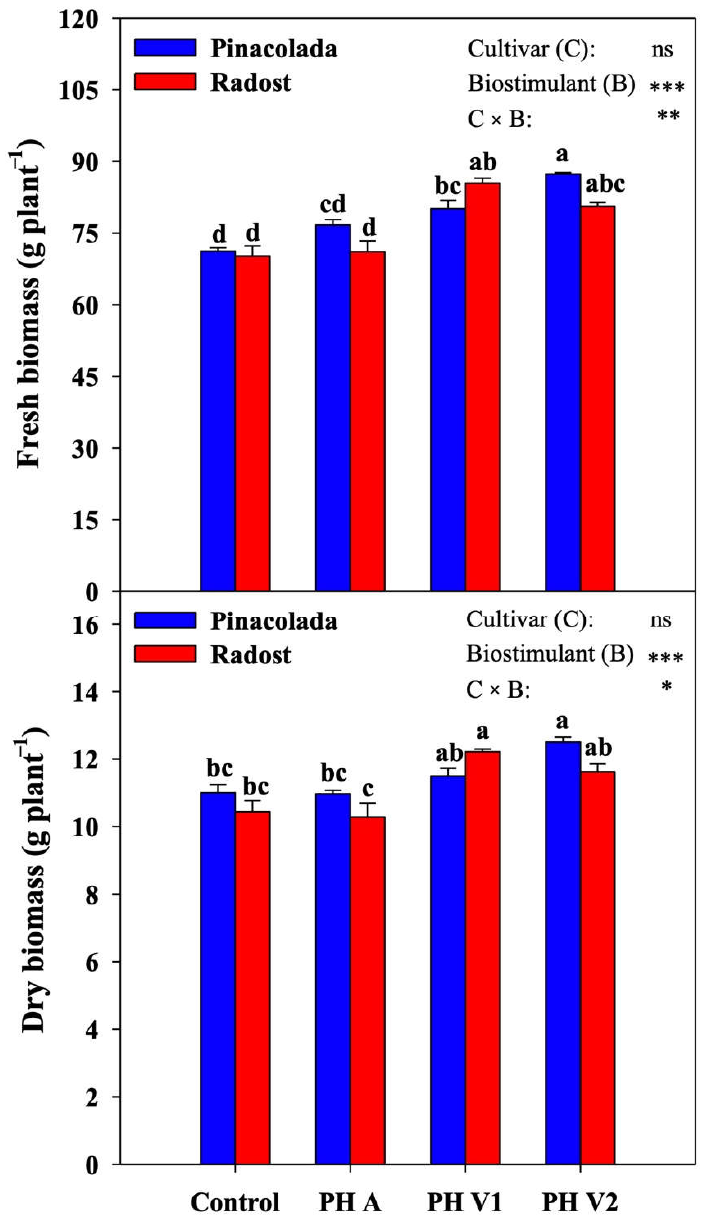
Figure 1. The effect of biostimulant treatments (untreated control, one animal PH (PH A, Hicure ® ) or two vegetal PHs (PH V1, Trainer ® and PH V2, Vegamin ® )) on fresh and dry biomasses of two chrysanthemum cultivars (Pinacolada and Radost) grown under greenhouse conditions. ns, *, **, *** Nonsignificant or significant at p ≤ 0.05, 0.01, and 0.001, respectively. Different letters within each column indicate significant differences according to Tukey’s HSD test ( p = 0.05).